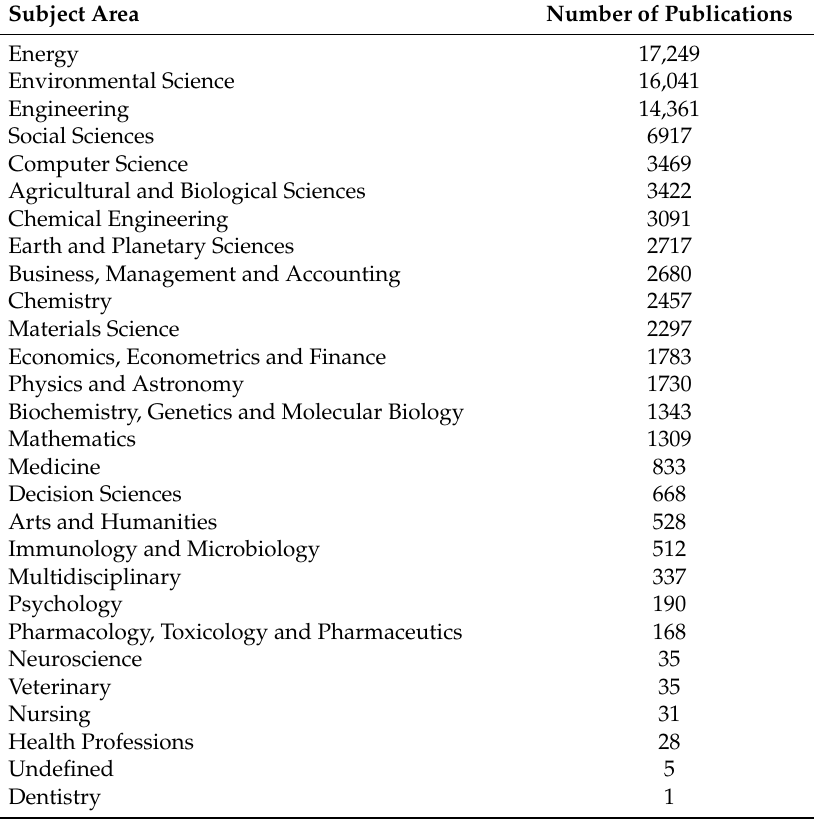
Table 2. Number of publication by subject